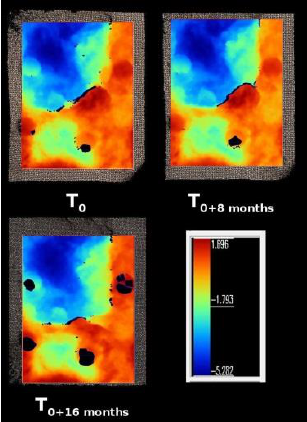
Figure 6. Differences in the elevation quotes (DEM) from images taken on the test surface of the calcareous stone (Santa Croce cathedral, Lecce) in